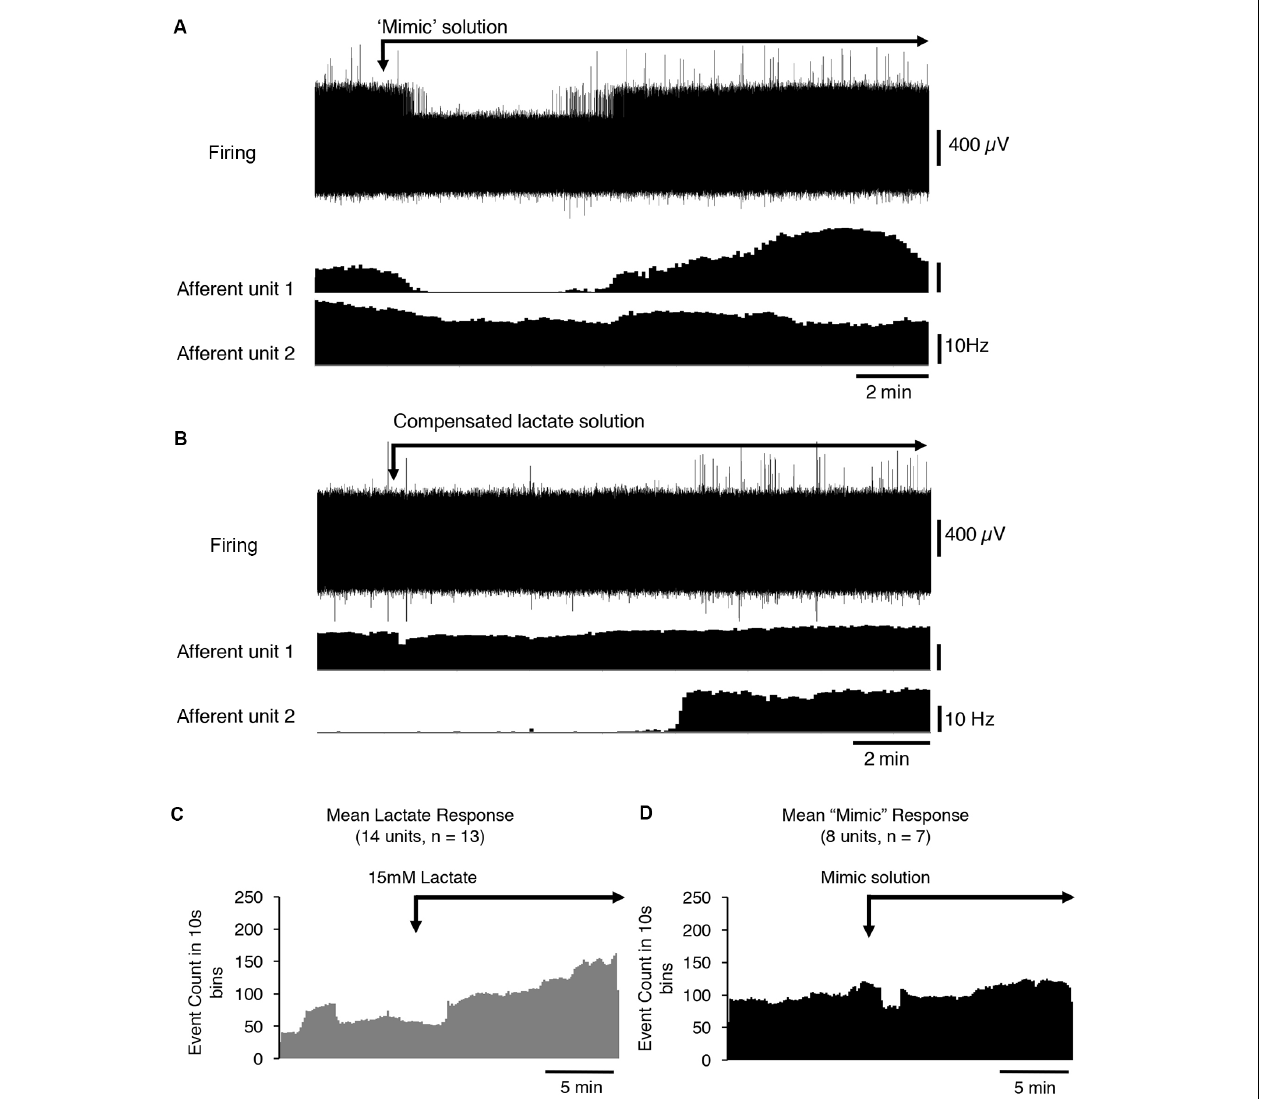
FIGURE 3 | The response of CT3 afferents to low Ca 2+ and Mg 2+ “mimic” solution and compensated lactate solution. (A) Responses of two identified CT3 afferents recorded in a single nerve to the application of a “mimic” solution’ containing reduced concentrations of Ca 2+ and Mg 2+ ions, which mimicked the chelating effects of lactate on divalent cations. One CT3 afferent (afferent unit 1) initially decreased, then increased firing after switching to the mimic solution. Afferent unit 2 showed a small, gradual decrease in the firing. Overall there was no significant effect of the mimic solution ( P = 0.7431, t = 0.3411, df = 7, paired t -test). (B) The application of 15 mM lactate, with raised [Mg 2+ ] and [Ca 2+ ] (to compensate for chelation effects) modestly activated unit 1 and was associated with a larger effect, after a delay, in Unit 2. This suggests that the effects of lactate are not due to the reduction in the availability of the divalent cations. (C) The mean response of 14 identified CT3 units, ( n = 13) to 15 mM lactate applied by superfusion in normal buffered solution (same as Figure 2B –included here for comparisons). (D) Mean response of eight units ( n = 7) to the “mimic” solution with reduced [Ca 2+ ] and [Mg 2+ ] to emulate the chelating effects of 15 mM lactate. Note that the “mimic” solution did not replicate the effect of 15 mM lactate shown in (C) .